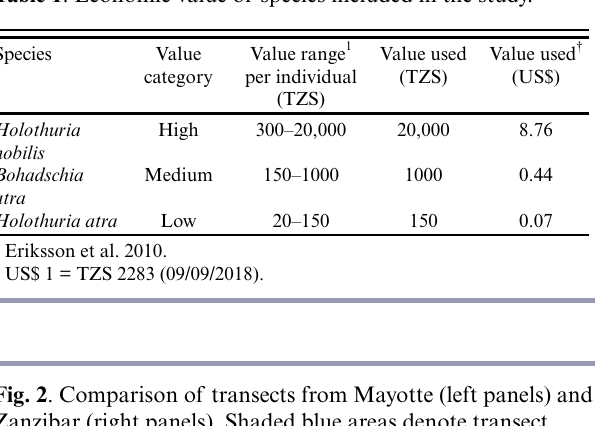
Table 1 . Economic value of species included in the study.